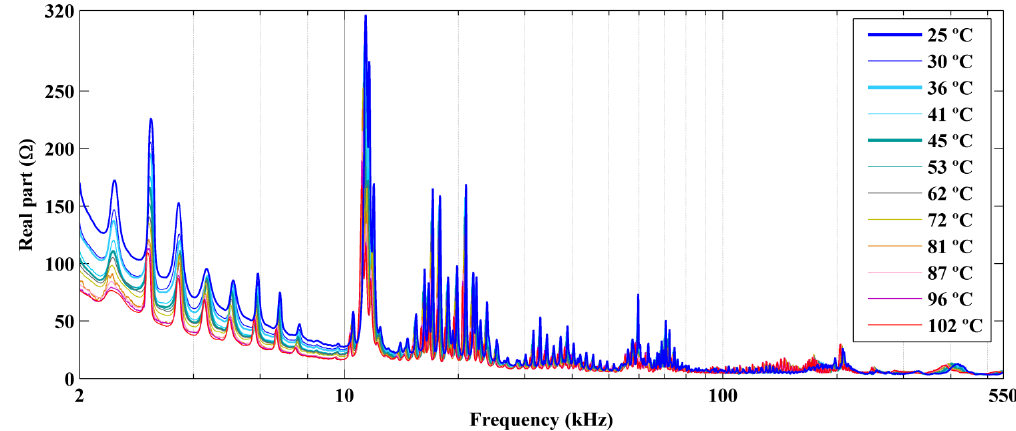
Figure 7. Real part of the impedance signatures obtained at different temperatures.